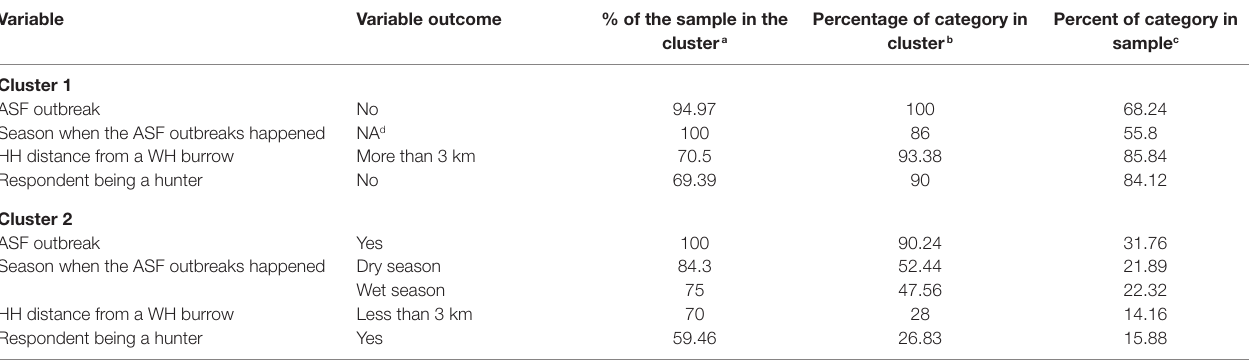
a Percentage of the sample in the cluster = % of individuals with the variable outcome in the study population who are in the cluster. b Percentage of category in cluster = % of individuals in the cluster with the variable outcome. c Percentage of category in sample = % of the variable in the study population. d NA, not applicable, no ASF outbreak was reported by the respondent.